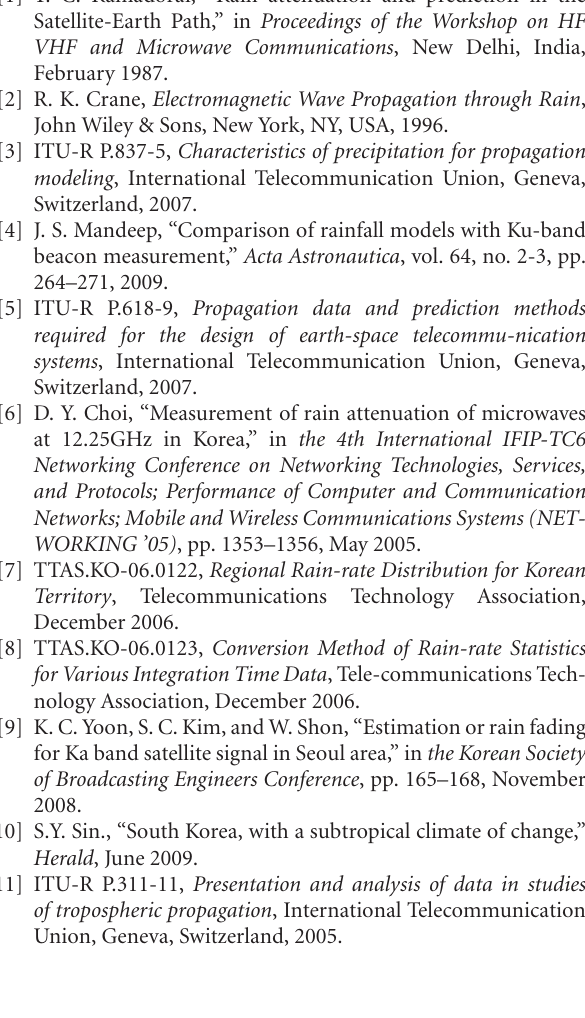
Table 2: Error, mean, standard deviation, and % RMS for each of the measured with respect to time percentage. Percentage error between the measured and the existing model for rain attenuation % Time 0.005 0.01 0.02